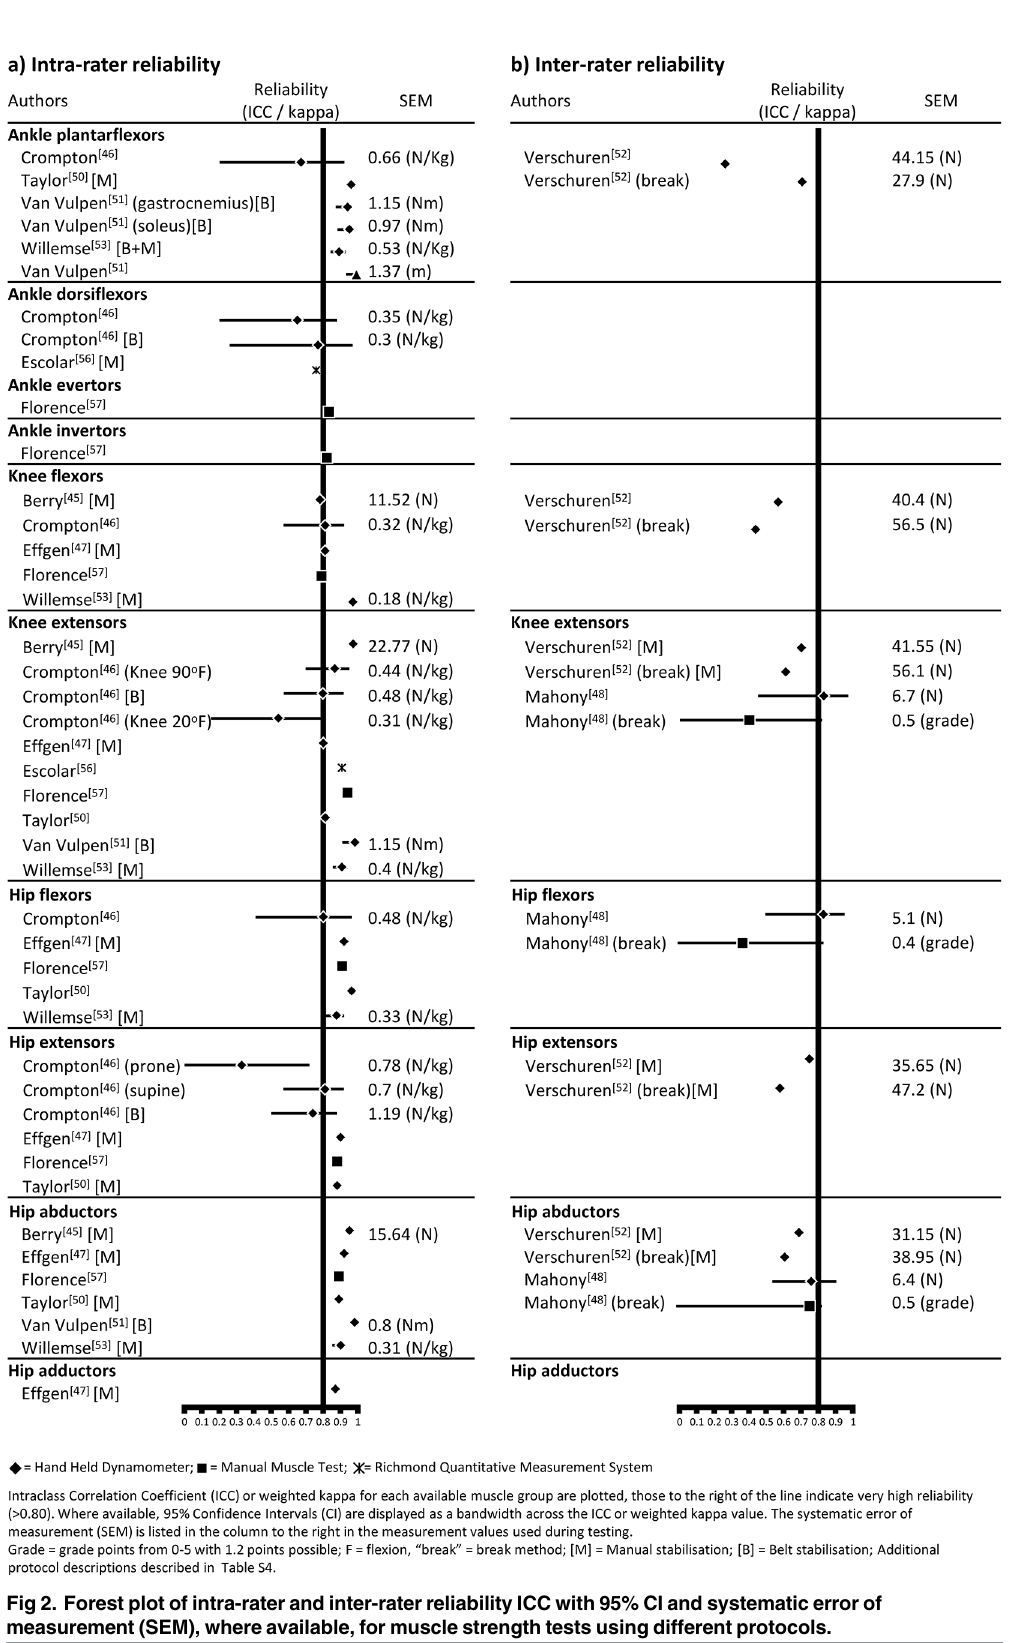
Fig 2. Forest plot of intra-rater and inter-rater reliability ICC with 95% CI and systematicerror of measurement (SEM), where available, for muscle strength tests using different protocols.